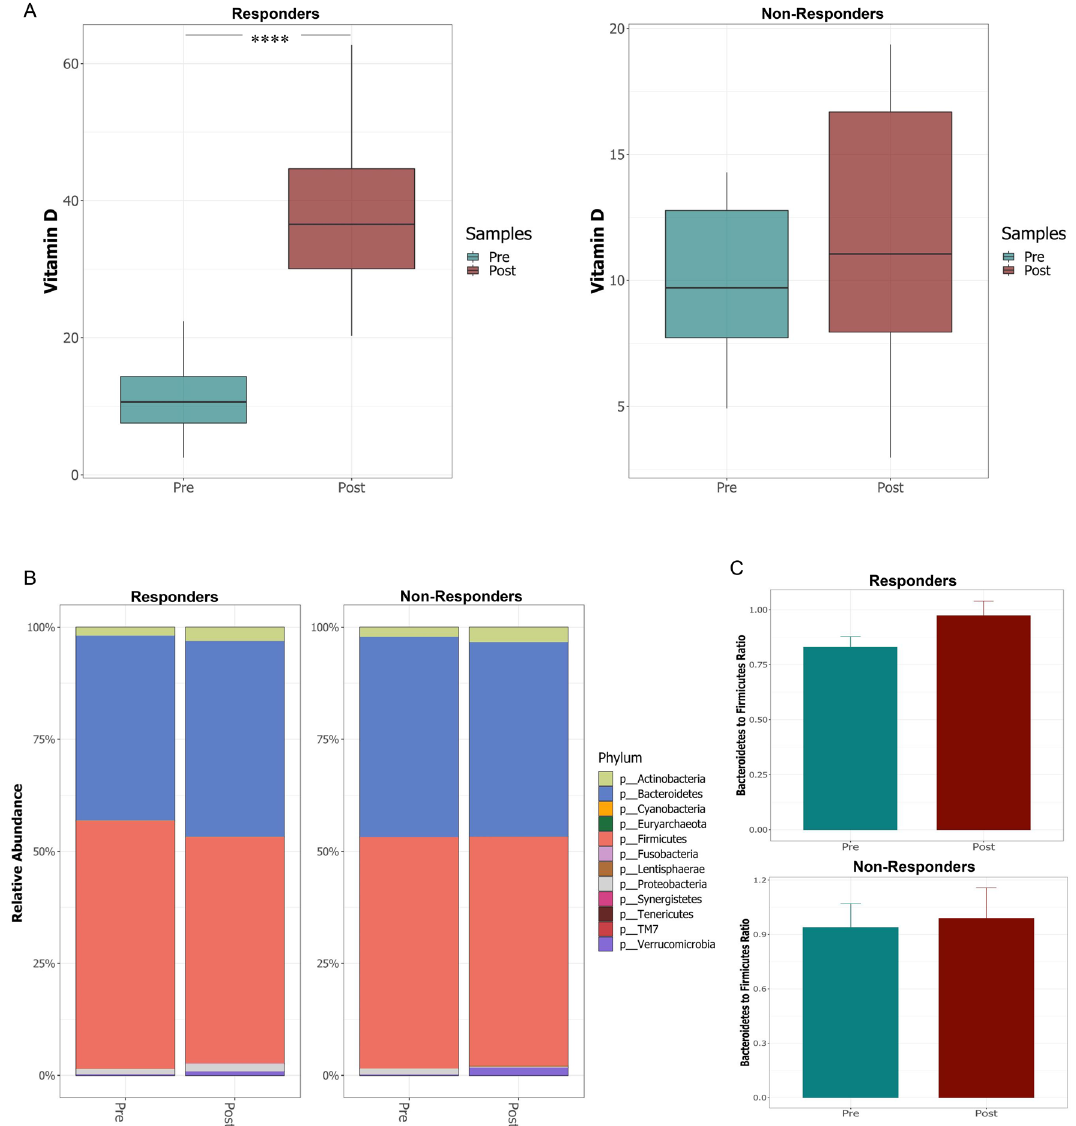
Figure 4. Comparison of changes in serum vitamin D levels (ng/ml) and gut microbiota composition in responders and non-responders to vitamin D supplementation. ( A ) Serum vitamin D levels pre- and post- supplementation in responders and non-responders. ( B ) Relative abundance of different bacterial phyla pre and post supplementation in responder and non-responder groups. ( C ) The ratio of Bacteroidetes to Firmicutes in responders and non-responders, pre- and post- vitamin D supplementation. The figure were generated using (RStudio v 1.2 with R v 3.6) 87